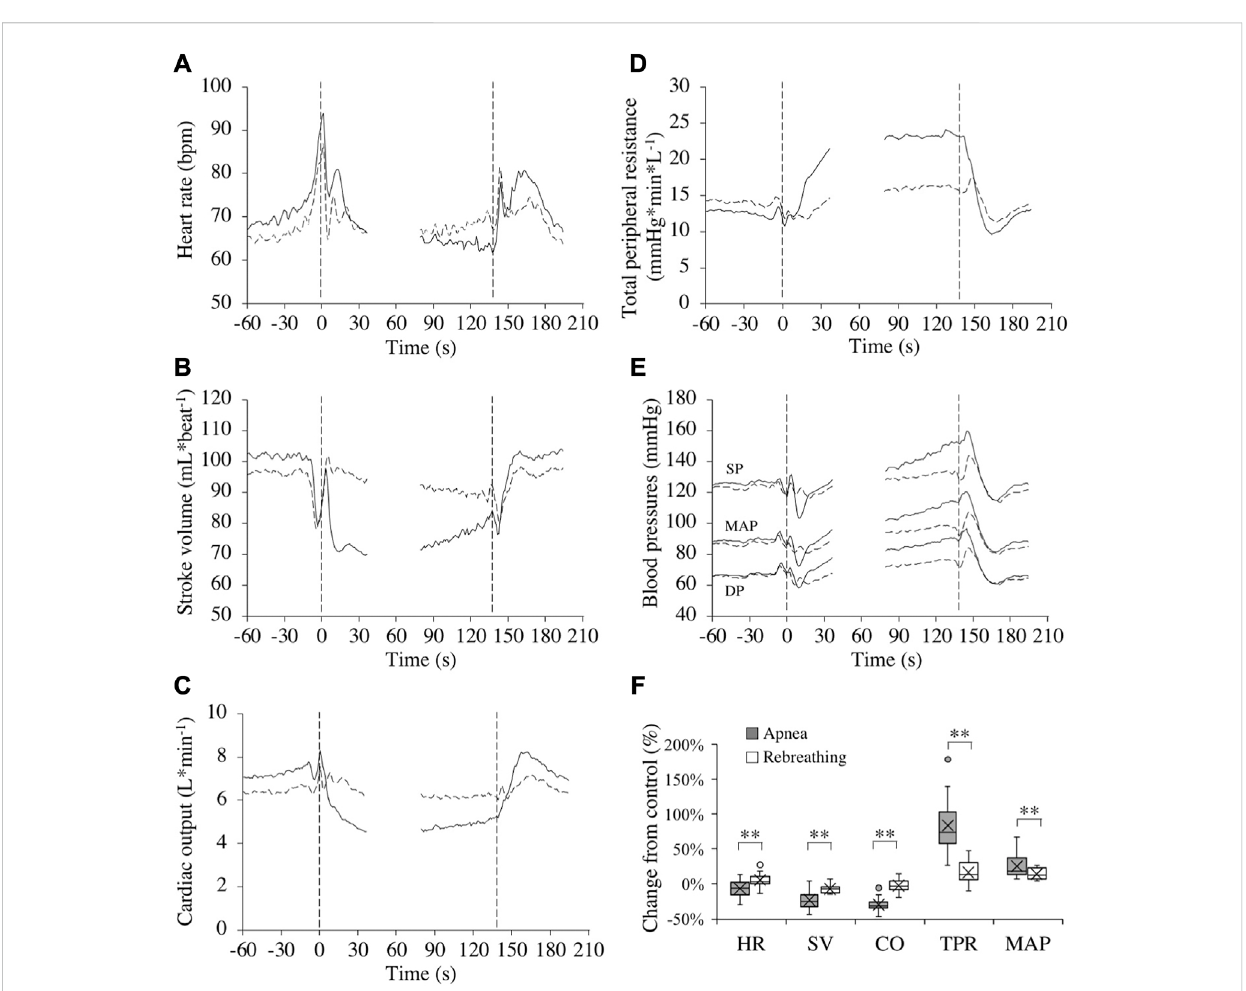
FIGURE 3 Cardiovascular responses ( n = 17 or 18, see text) in association with apneas (solid lines) and rebreathing periods (dashed lines). Panel 3 (A – E) show themeansofeachvariablefrombeforetests( – 60 – 0 s),duringthe fi rst35 softests(0 – 35 s),duringthelast60 softests(78 – 137 s),andthe fi rst60 safter tests (138 – 198 s). Vertical dashed lines indicate the start and end of apneas and rebreathing periods. Breaks in the lines re fl ect the fact that test durations variedamongthesubjects,andthepositionoftheendoftestsinthegraphshasbeenadjustedforeachsubjecttomatchtheaveragedurationofthe tests(137 s).Errorbarshavebeenomittedforclarity.Panel3 (F) showsboxplotsfortherelativechangesineachvariable(HR,heartrate;SV,strokevolume; CO, cardiac output; TPR, total peripheral resistance; MAP, mean arterial pressure) during 20 – 10 s before the end of apneas and rebreathing periods compared to their respective control value (see fi gure legend 2 for details). ** p < 0.01 between apnea and